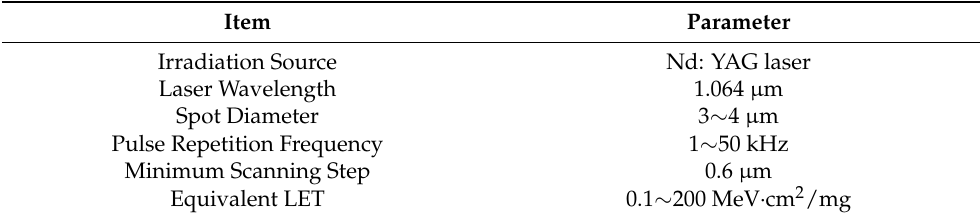
Table 1. Main technical parameters of pulsed laser single event effect test facility.